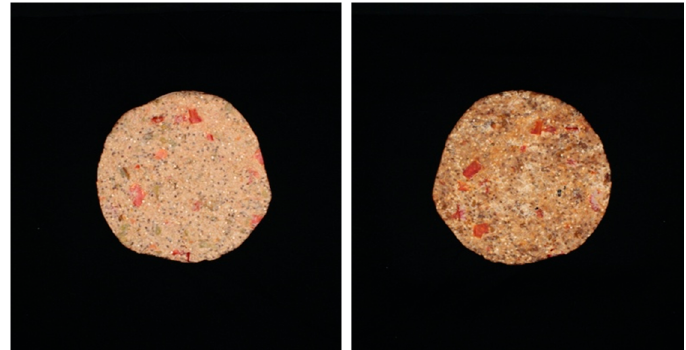
Figure 4 . Pictures of sample before ( left ) and after processing ( right ). Figure 4. Pictures of sample before ( left ) and after processing ( right